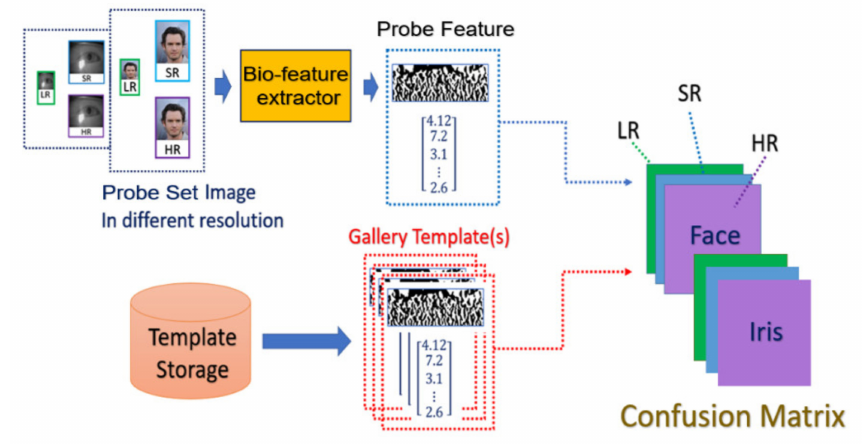
Figure 8. The flowchart of the matching stage.